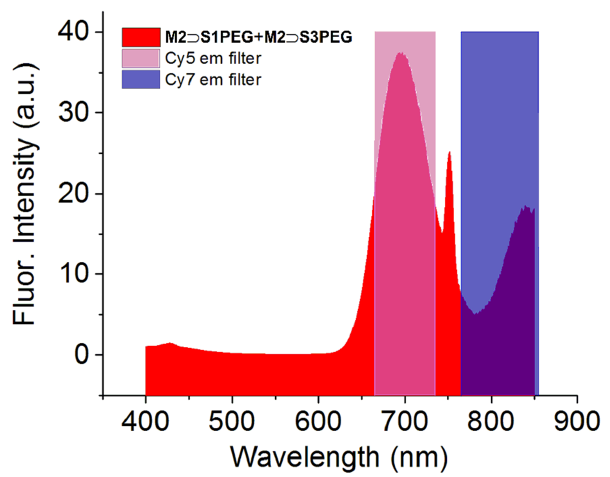
Figure 7. Two color emission by single excitation (375 nm) of a 1:1 mixture containing M2 ⊃ S1PEG and M2 ⊃ S3PEG in H 2 O. The peak at 750 nm is an artifact caused by the excitation at 375 nm.